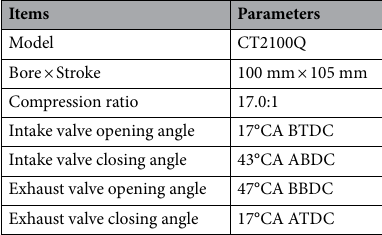
Table 1. The specifications of test